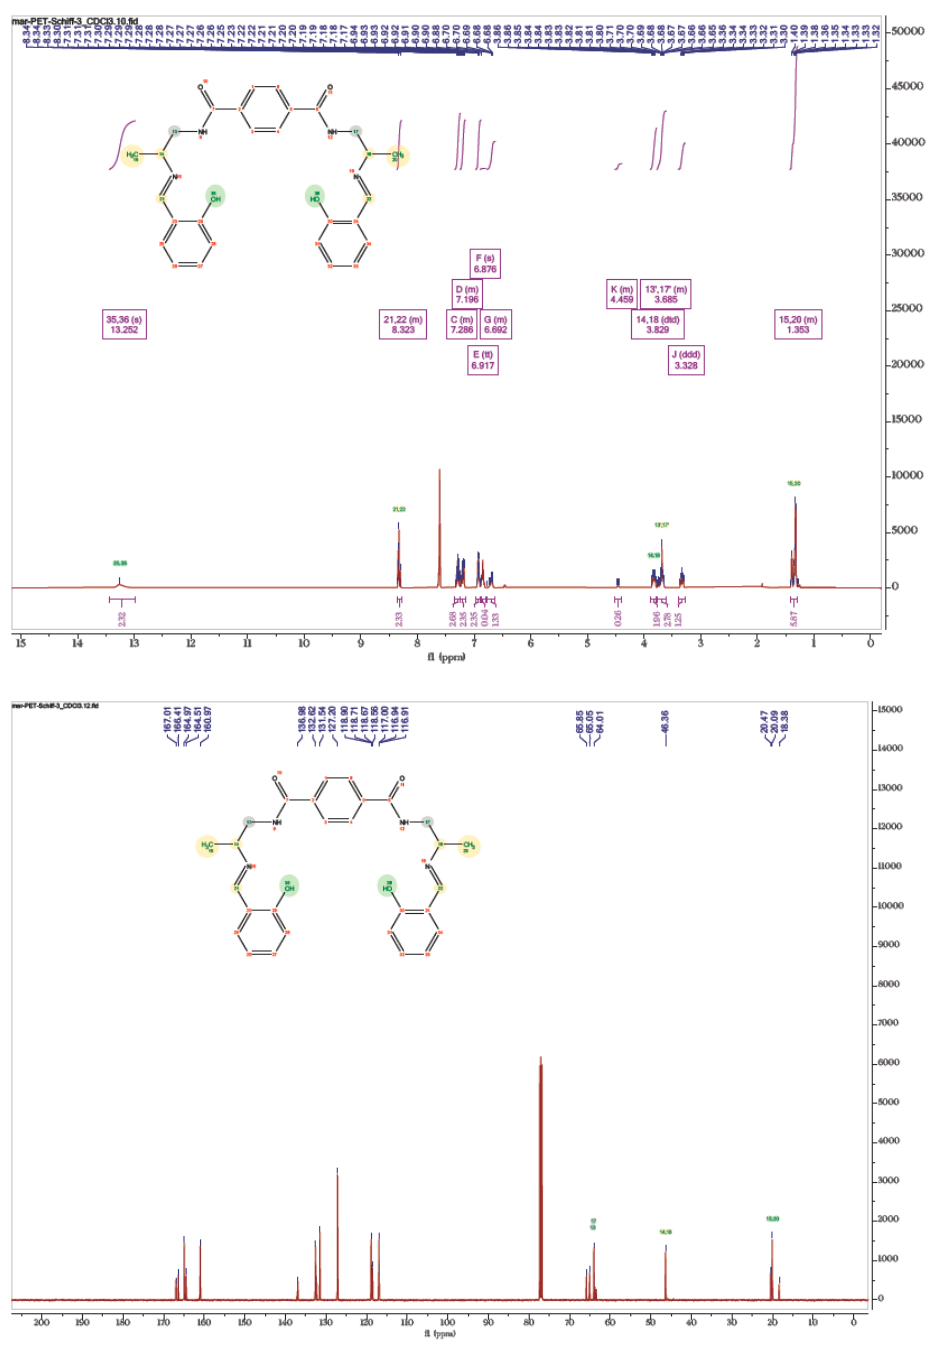
Figure 6. 1 H and 13 C NMR spectra of the Schiff base (5).